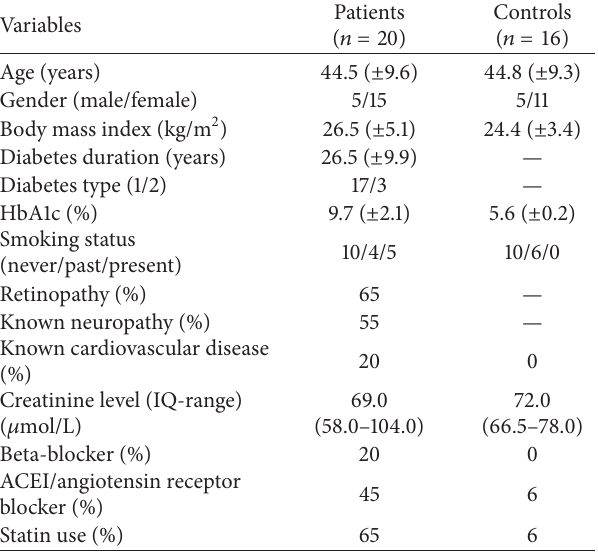
Table 1: Clinical